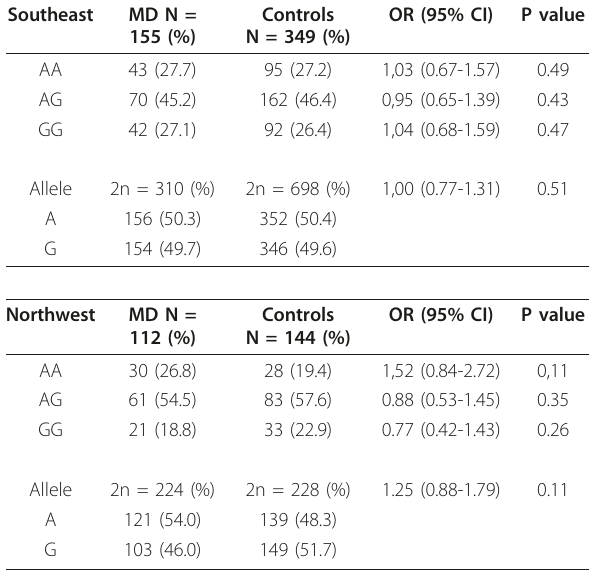
Table 4 Frequency of CD32 alleles and genotypes